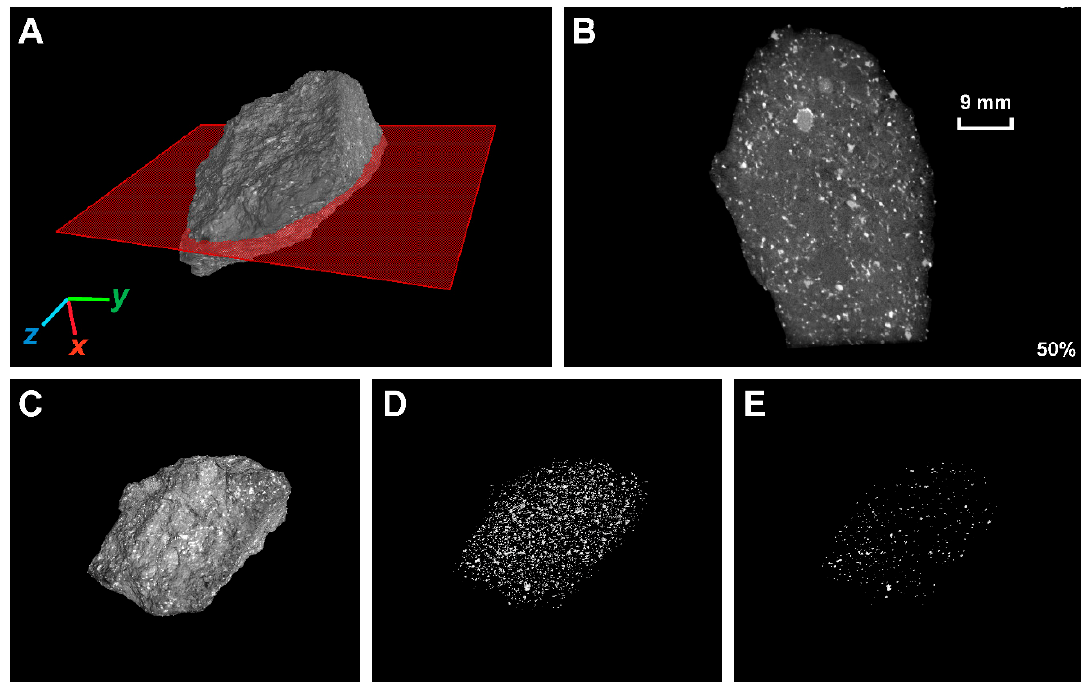
Figure 2. ( A , B ) CT scan display of a section in which the whitest grains are Fe-Ni, pale grey is troilite, intermediate grey is iron-silicates, and darker areas are plagioclase. The CT scan technique offers similar images in quality to those obtained by backscattering, with the added benefit of being able to observe an internal section using a non-destructive technique. ( C – E ) show section visualizations with different grades of density filter; in all probability the last image ( E ) corresponds to a plot of the spatial distribution of Fe-Ni masses.